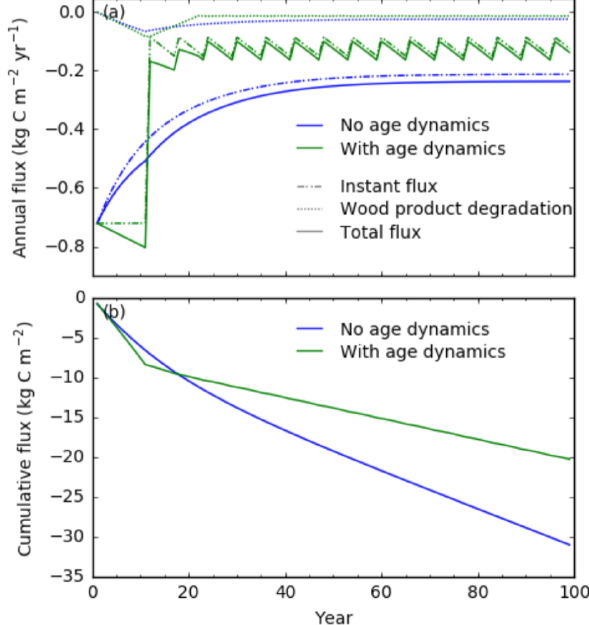
Figure 7. (a) Carbon fluxes directly associated with LUC (negative values for carbon lost from ecosystems): instantaneous flux (dash- dotted line), flux from wood product degradation (dotted line), and the total flux (solid line) for simulations with (green) and without (blue) sub-grid age dynamics. (b) Cumulative LUC-associated di- rect fluxes (the sum of instantaneous and wood product degradation fluxes) for simulations with (green) and without (blue) sub-grid age dynamics. Data are shown for an annual forest–cropland turnover of 5% of the grid cell area for 100 years.